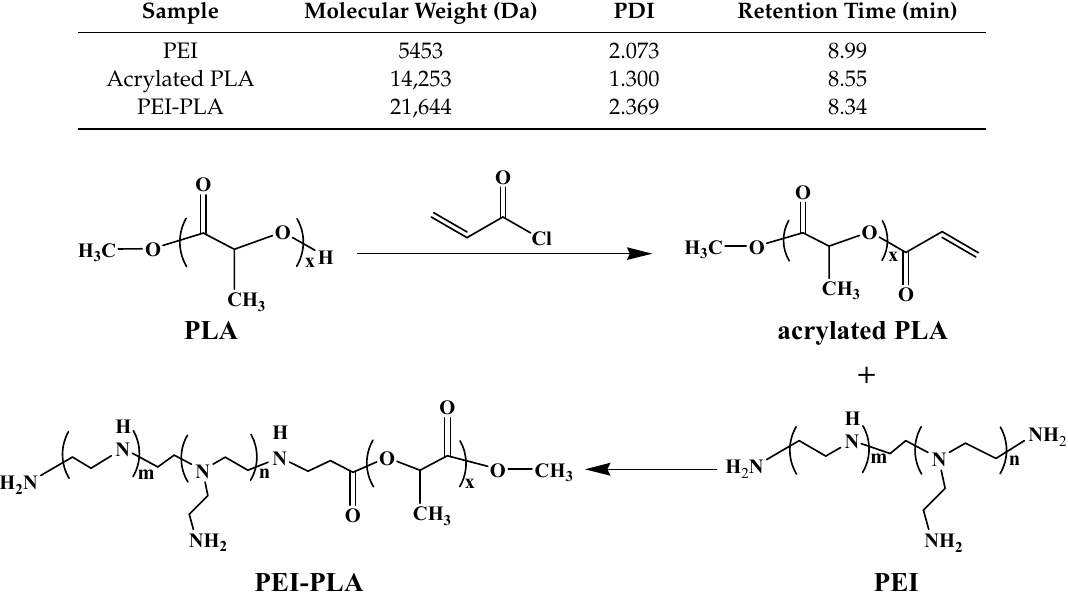
Figure 2. ( a ) GPC chromatograms of PEI, acrylated PLA and PEI-PLA copolymer; ( b ) 1 H NMR spectrum of PEI-PLA copolymer in DMSO-d6, the inset represents magni fi cation of 5.8 − 6.7 ppm.